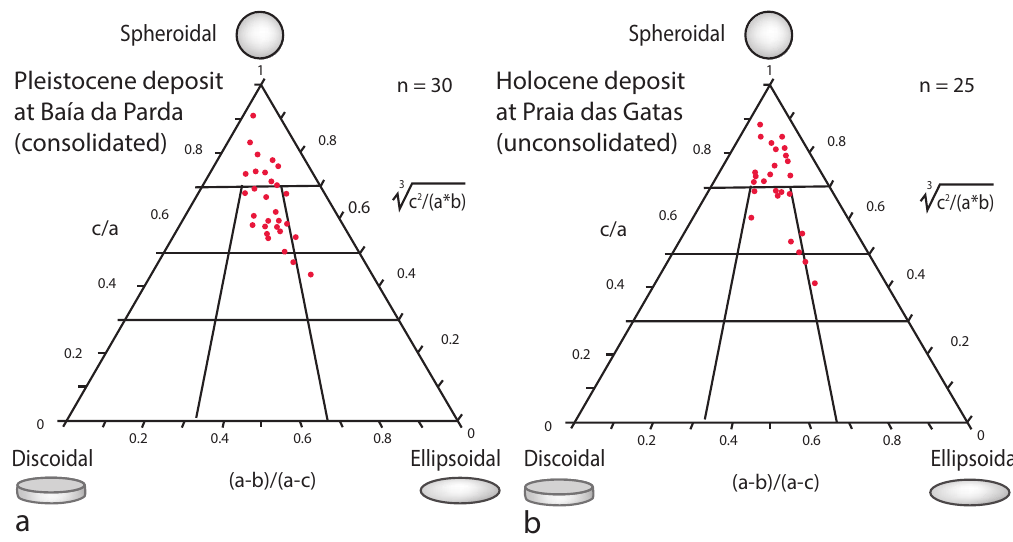
Figure 7. Set of triangular Sneed-Folk diagrams used to appraise variations in rhodolith shapes; ( a ) Plots from rhodoliths sampled from the consolidated deposit in Upper Pleistocene limestone on Bah í a da Parda; ( b ) Plots from unconsolidated Holocene deposit at Praia das